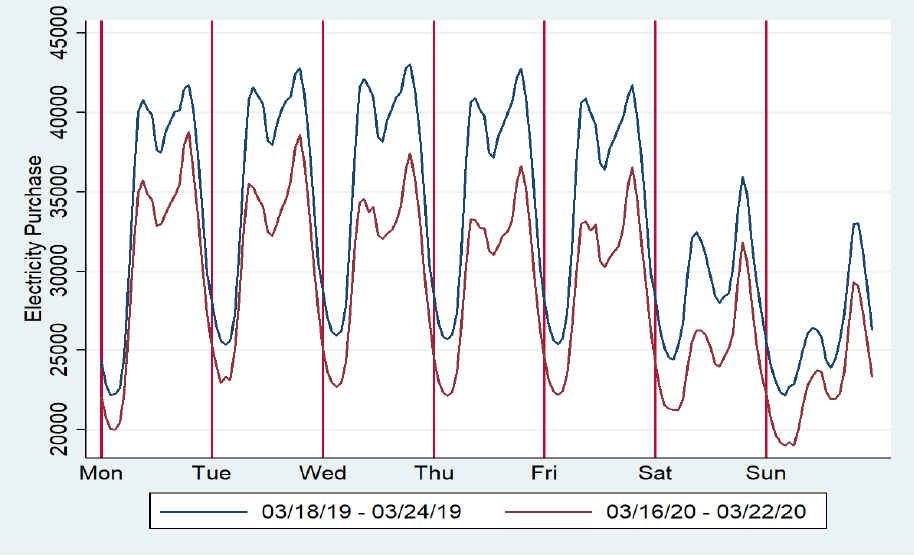
Figure 4. Weekly Load Profiles for the Third Week of March 2019 and 2020.